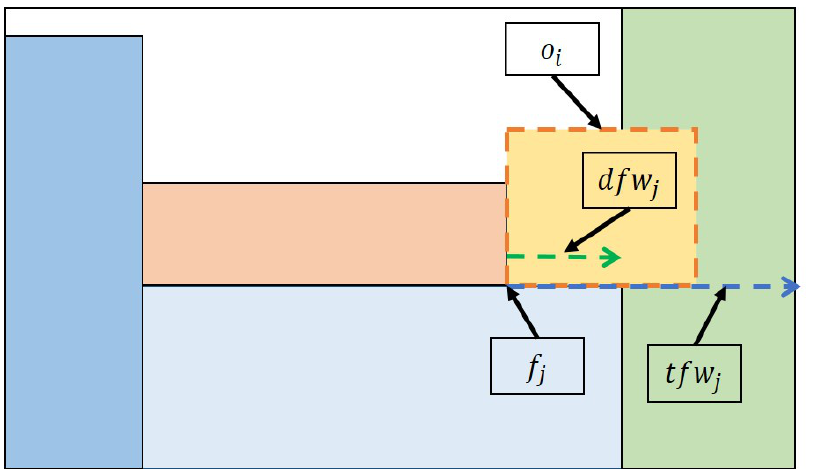
Figure 3. Overlaps between